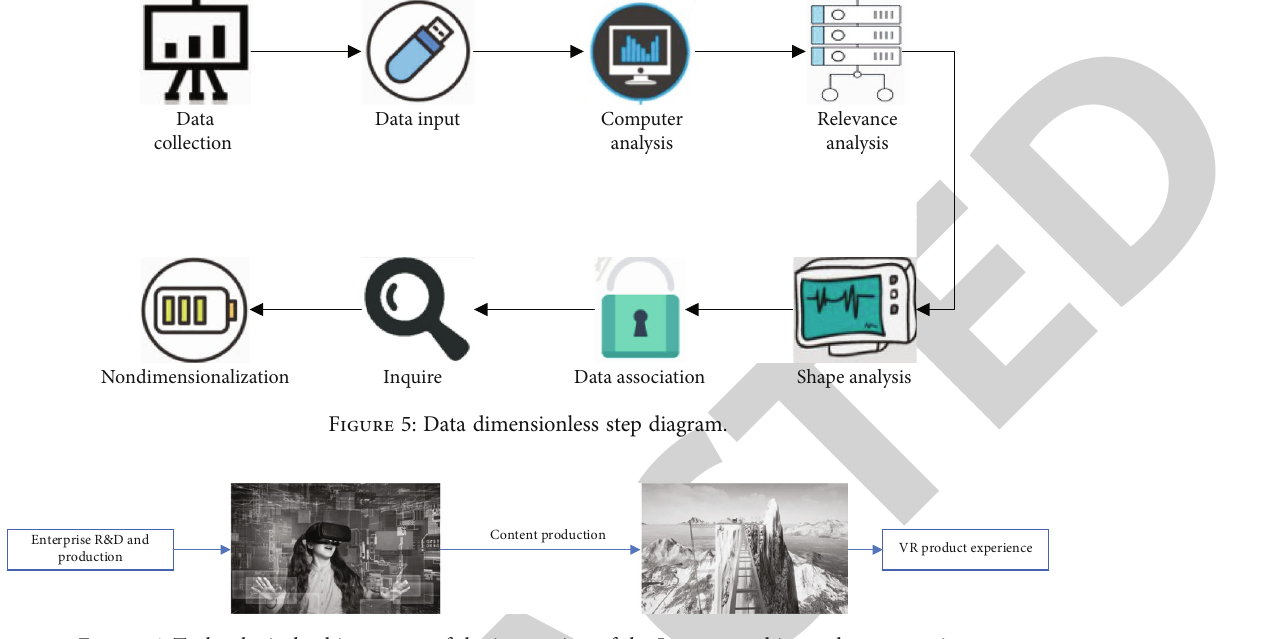
Figure 6: Technological achievements of the integration of the Internet and ice and snow tourism.